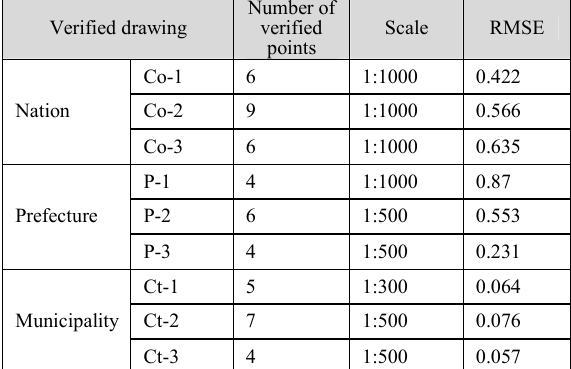
Table 3. Evaluation result of location accuracy of as-built drawings